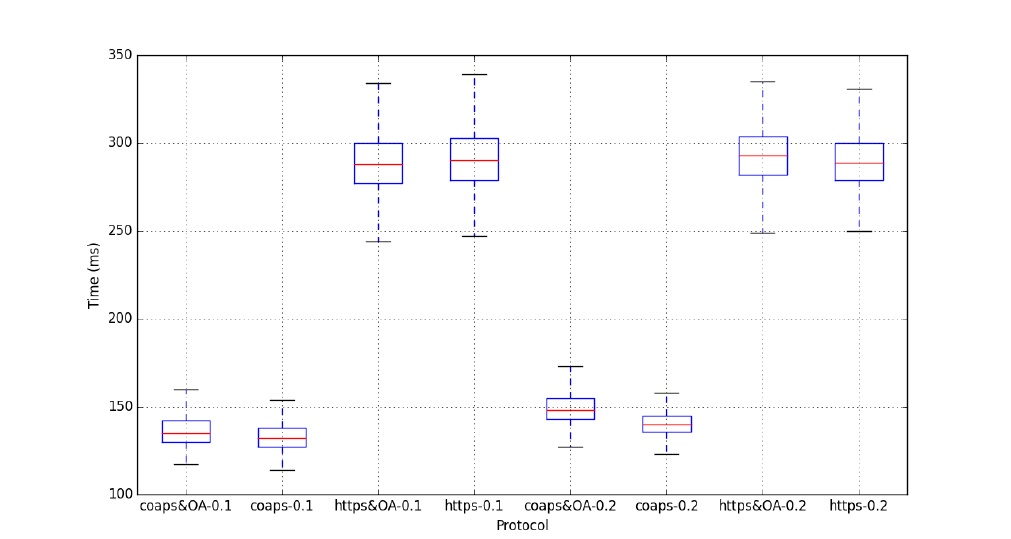
Figure 4. Latency for 0.1 and 0.2 s